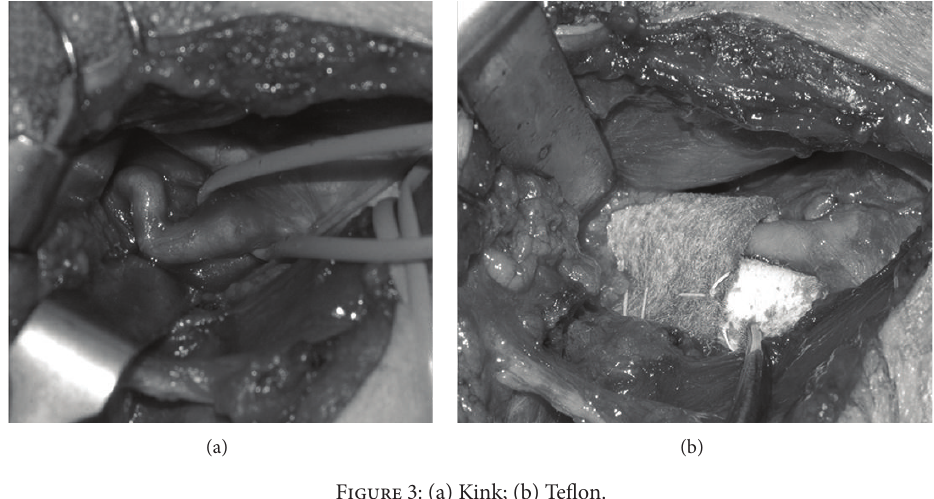
Figure 3: (a) Kink; (b) Teflon.